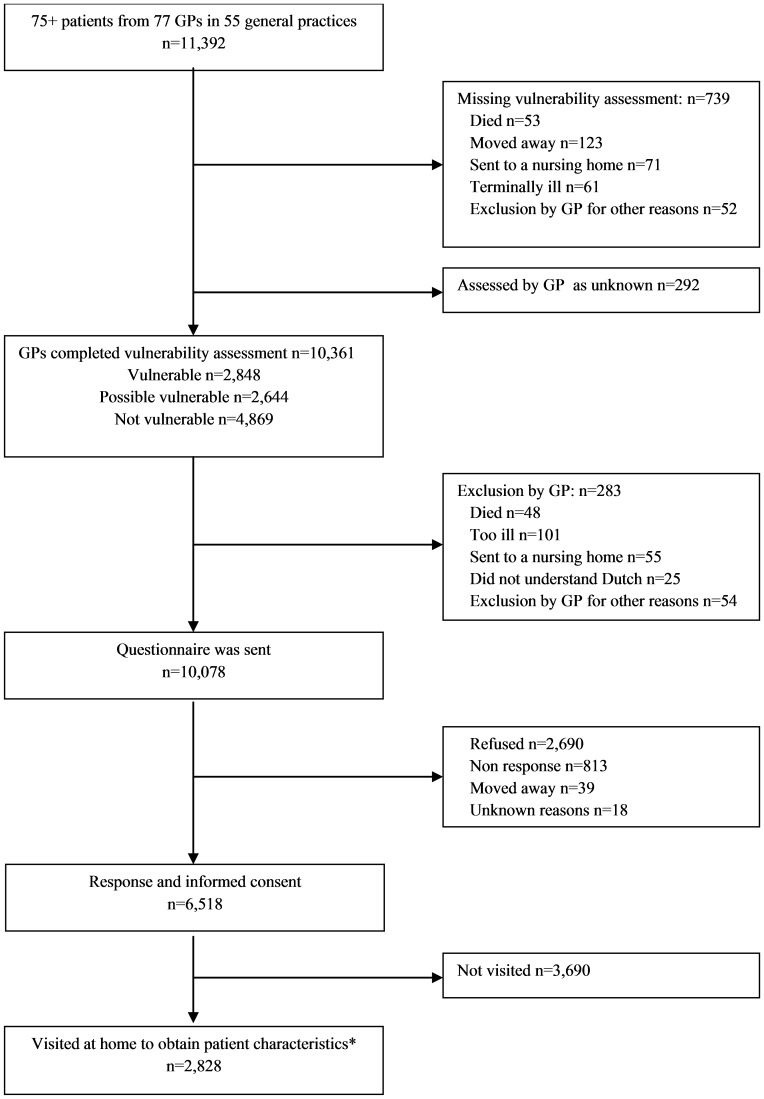
Flowchart from the start of the study with all registered patients of 77 general practitioners till the selection visited at home.*Selection based on the outcomes of the questionnaire: 15% of the participants with problems on 0 or1 domains of the questionnaire were visited, 60% of the participants with problems on 2 domains and all participants with problems on 3 or 4 domains.